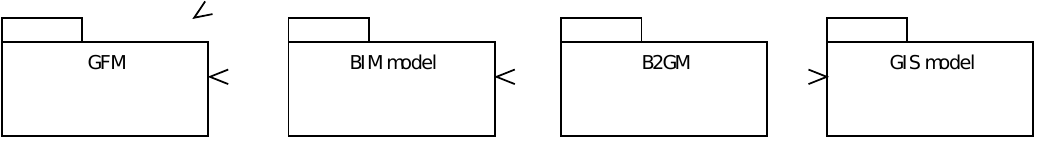
Figure 6. B2GM use cases.